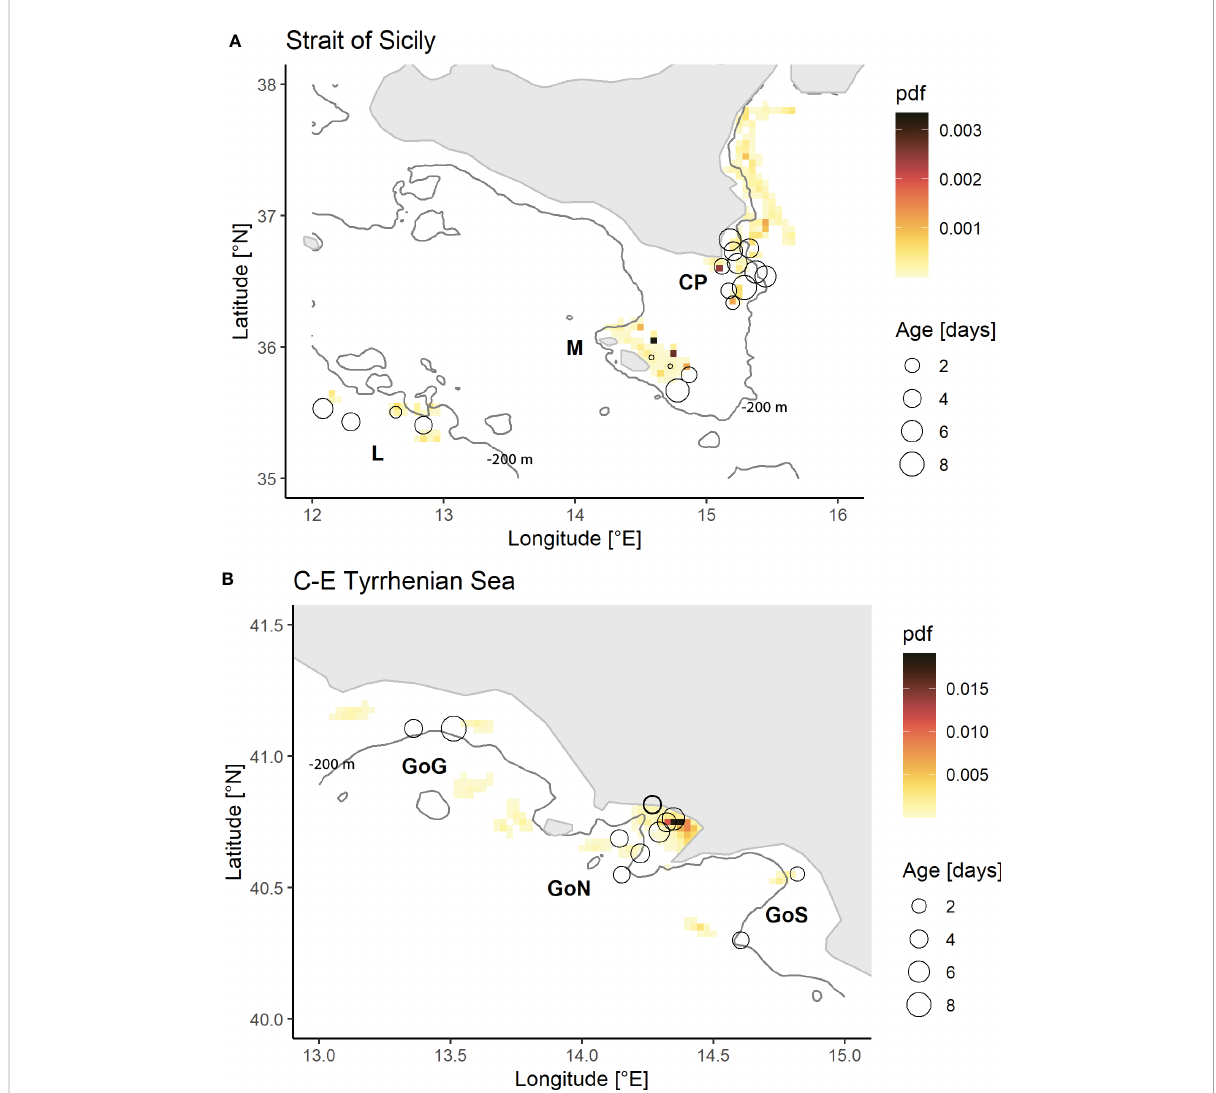
FIGURE 2 Reconstruction of the spawning areas located in the Strait of Sicily (A) and Central-Eastern Tyrrhenian Sea (B) , based on the probability distribution functions (PDFs) derived from Lagrangian simulations. The black circles indicate the release points of the particles in the backward Lagrangian simulations. Their positions correspond to the sampling stations of larvae selected for otolith readings according to the followed methodology, while their sizes are proportional to the mean age of larvae sampled in each release